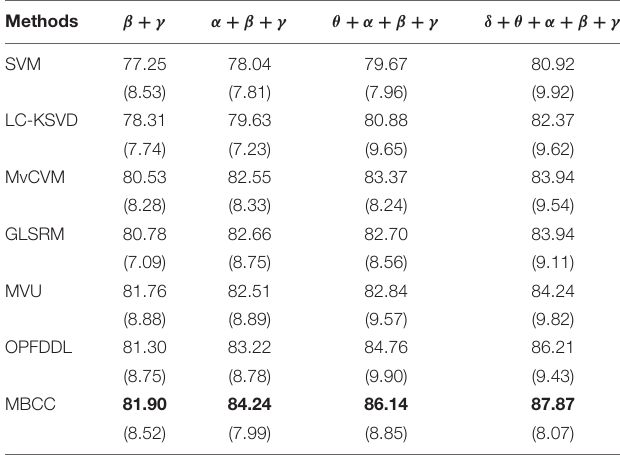
TABLE 3 | The accuracy (standard deviations) of all methods on SEED dataset in session 2.